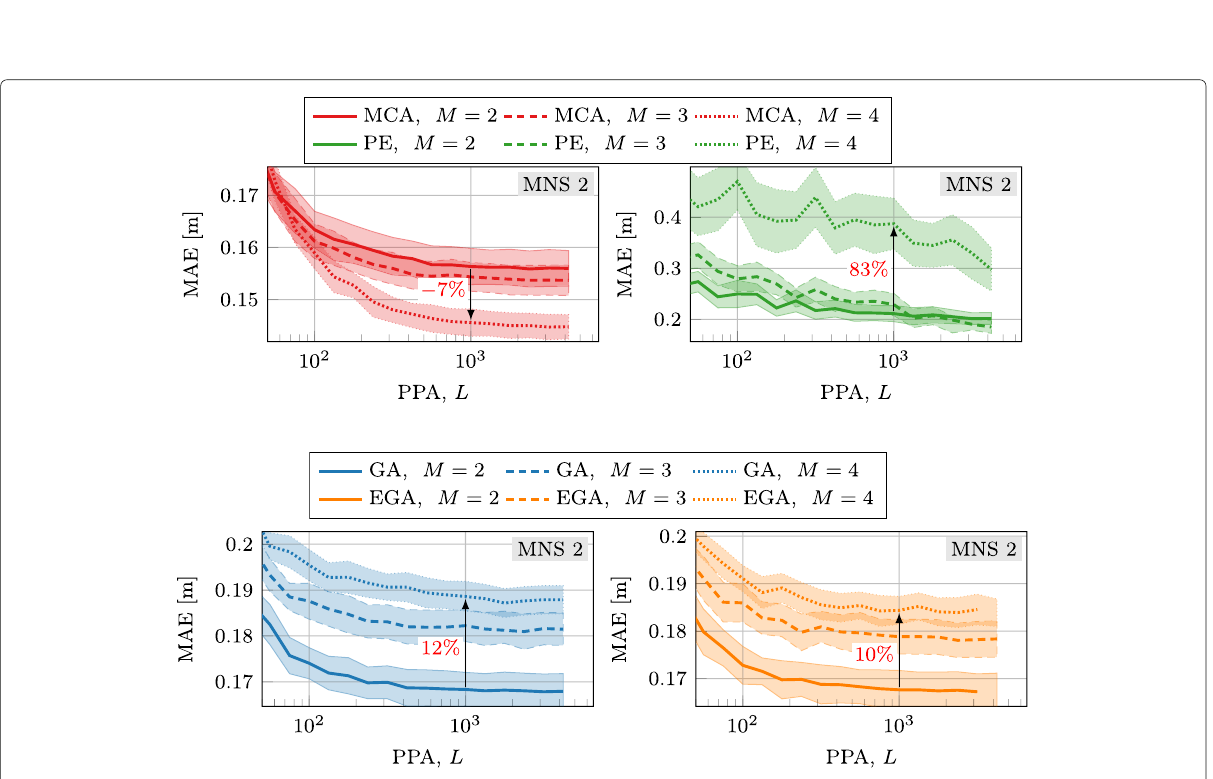
Fig. 9 Localization error as a function of the number of PPA for different numbers of agents to be tracked for MNS